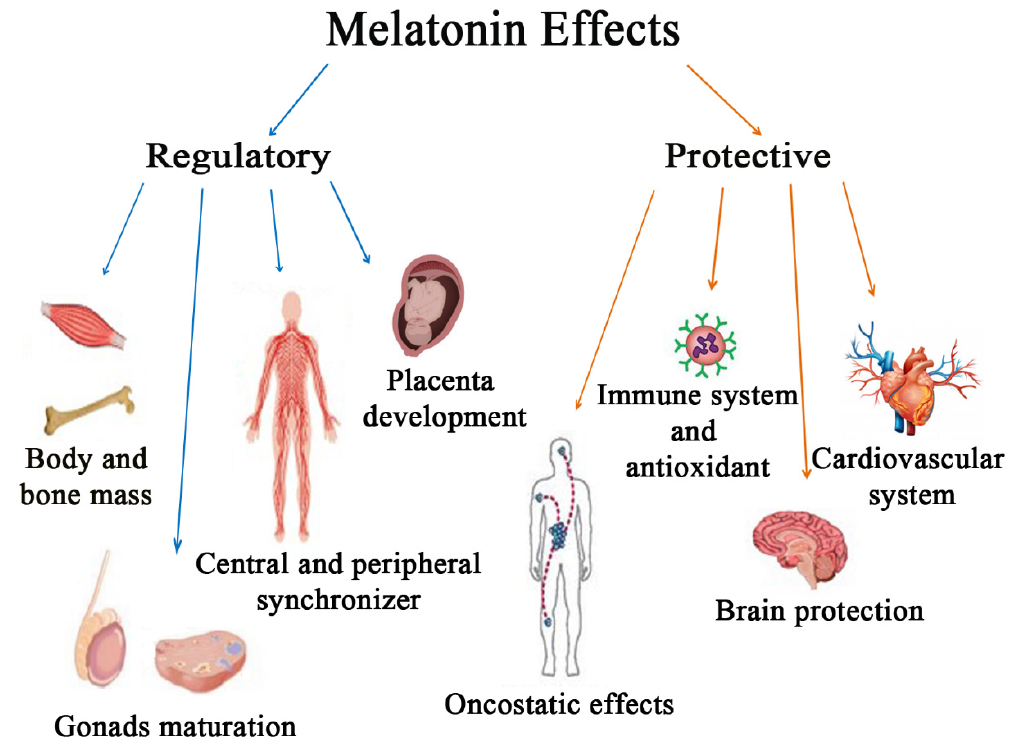
Figure 2. Pleiotropic actions of melatonin in human body.